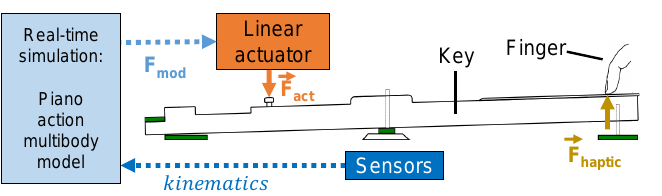
Figure 10. Piano action multibody model force feedback principle, adapted from the work in [30].